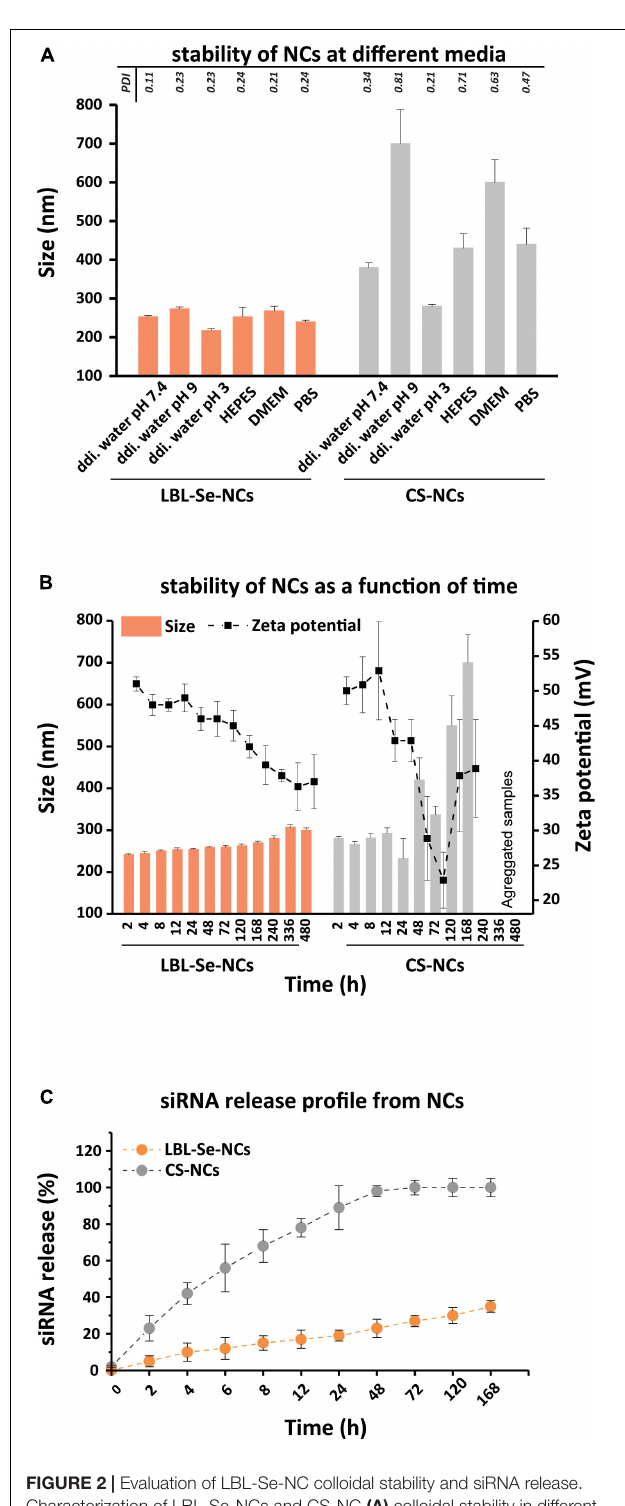
FIGURE 2 | Evaluation of LBL-Se-NC colloidal stability and siRNA release. Characterization of LBL-Se-NCs and CS-NC (A) colloidal stability in different media: ddi. water (pH 7.4, 3, 9), DMEM, HEPES, PBS. (B) Colloidal stability as a function of time in RNase-free water as measured by DLS and zeta potential. (C) siRNA release profile from LBL-Se-NCs and CS-NCs as a function of time. Bars represent mean ± SEM, for a minimum of three independent